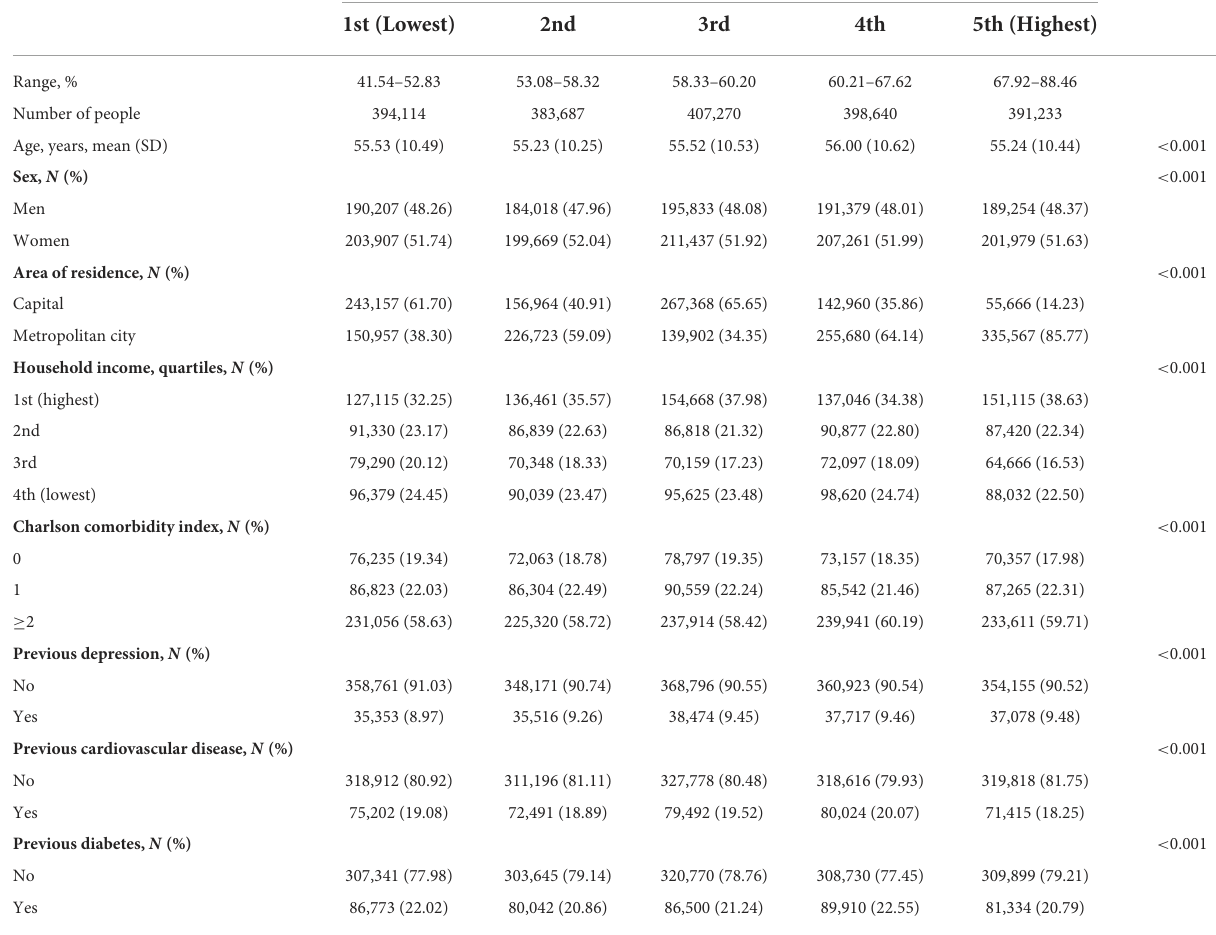
TABLE 1 Descriptive characteristics of the main study